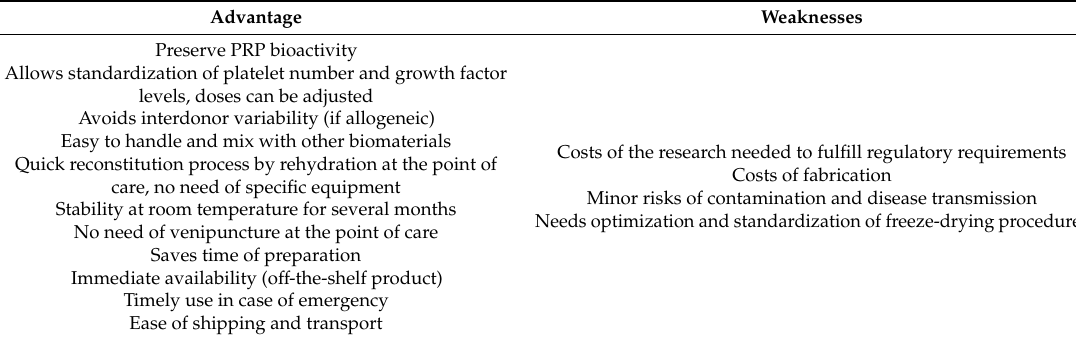
Table 4. Advantages and weaknesses of freeze-dried platelet-rich